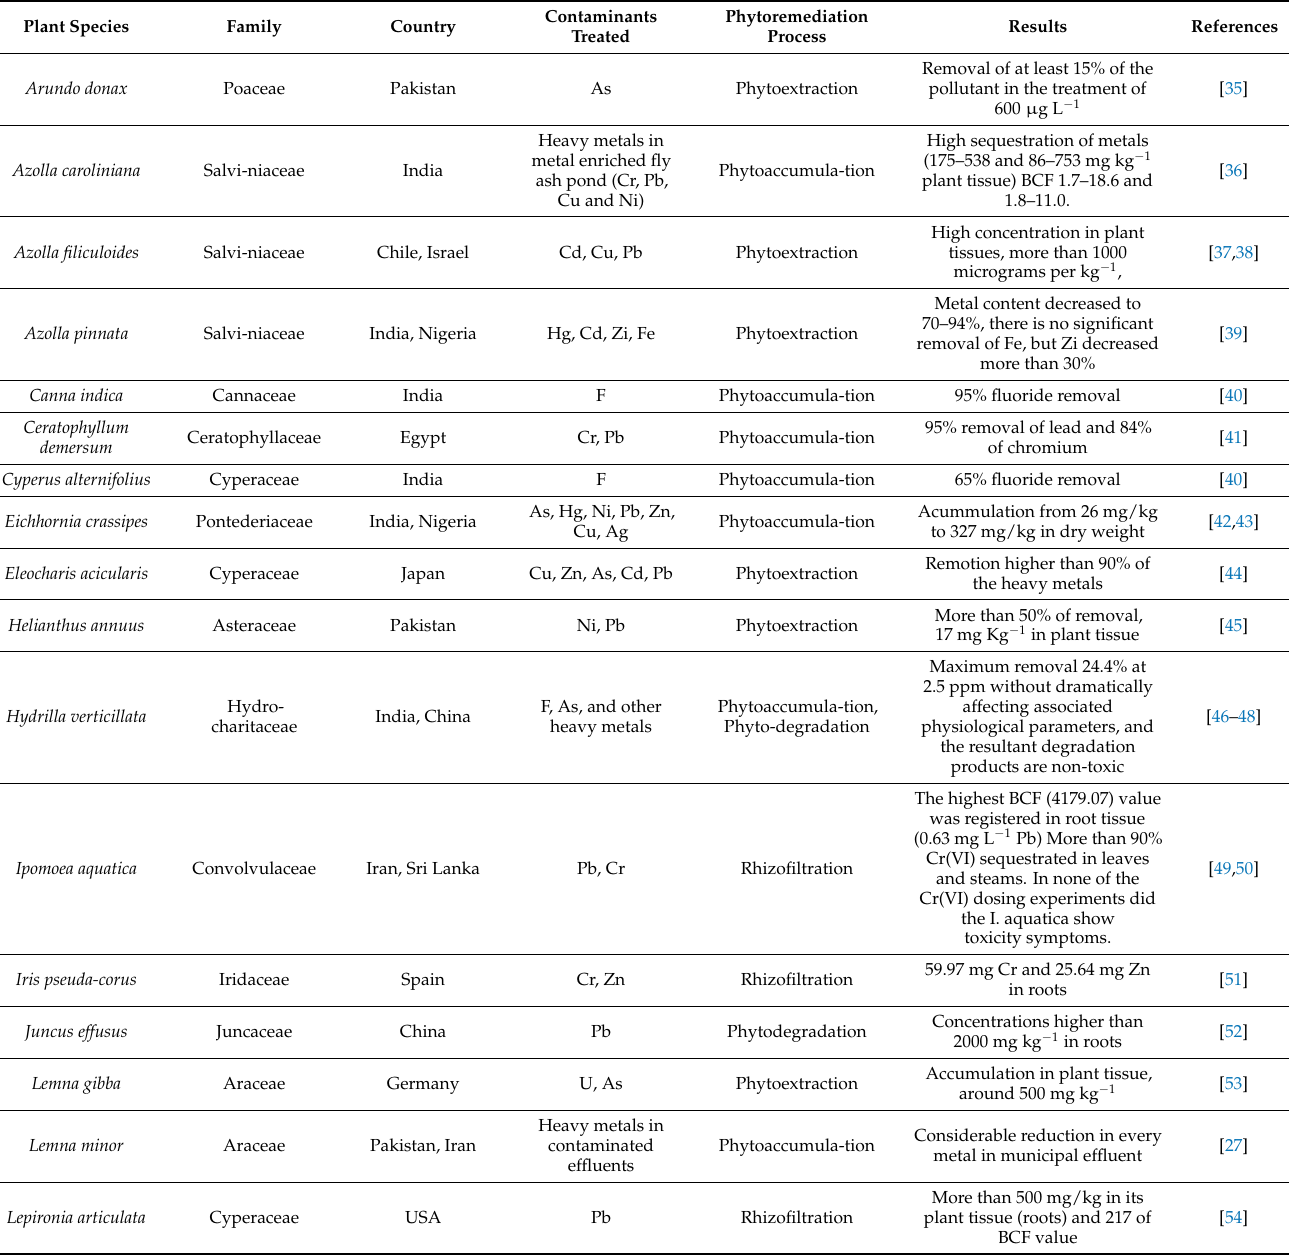
Table 1. Data from 40 species analyzed in studies related to phytoremediation in water. The presented data were published in studies between 2000 and